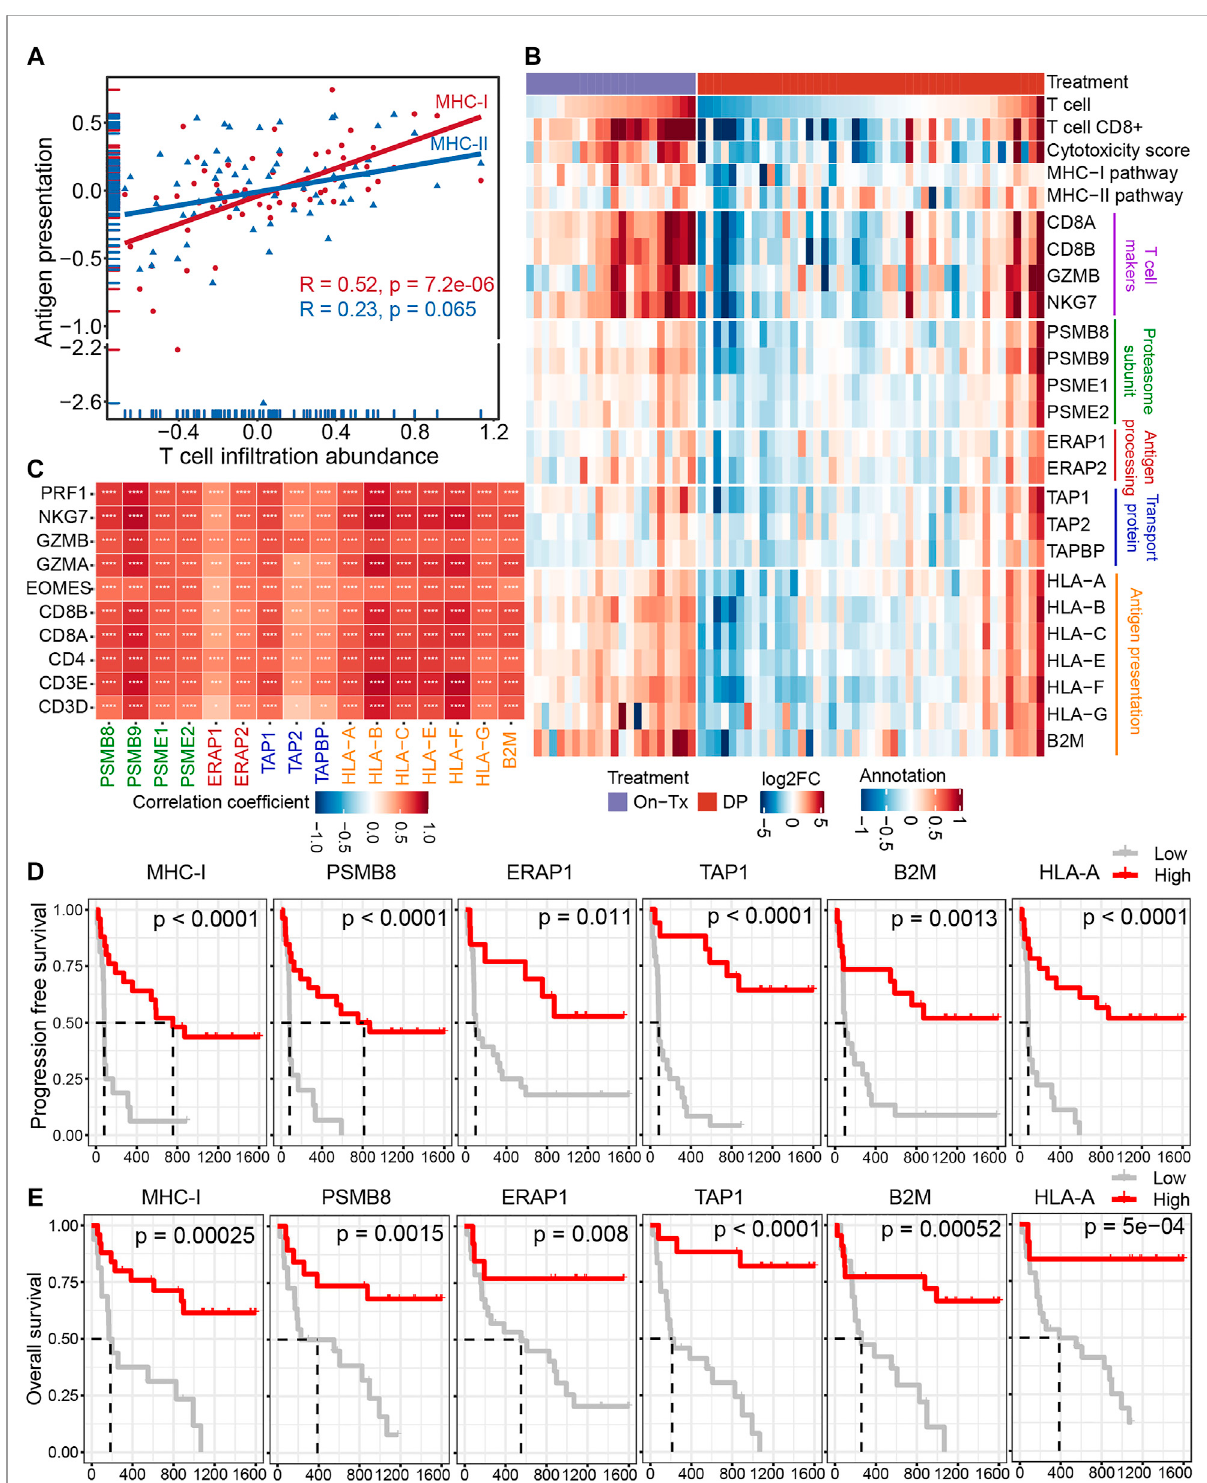
FIGURE 4 Decreased in fi ltration of T cells was regulated by MHC-I antigen presentation during MAPK-targeted therapy. (A) Pearson ’ s correlations between MHC class I (MHC-I) and MHC class II (MHC-II) antigen processing and presentation pathways and abundance of T cell in fi ltration were calculated, respectively (GSE75313, GSE65185, and EGAS00001000992). The value used to calculate the correlation was log2FC expression between MAPKi-treated and baseline biopsies. (B) Heatmap showing log2FC expression changes of T cell marker genes and genes involved